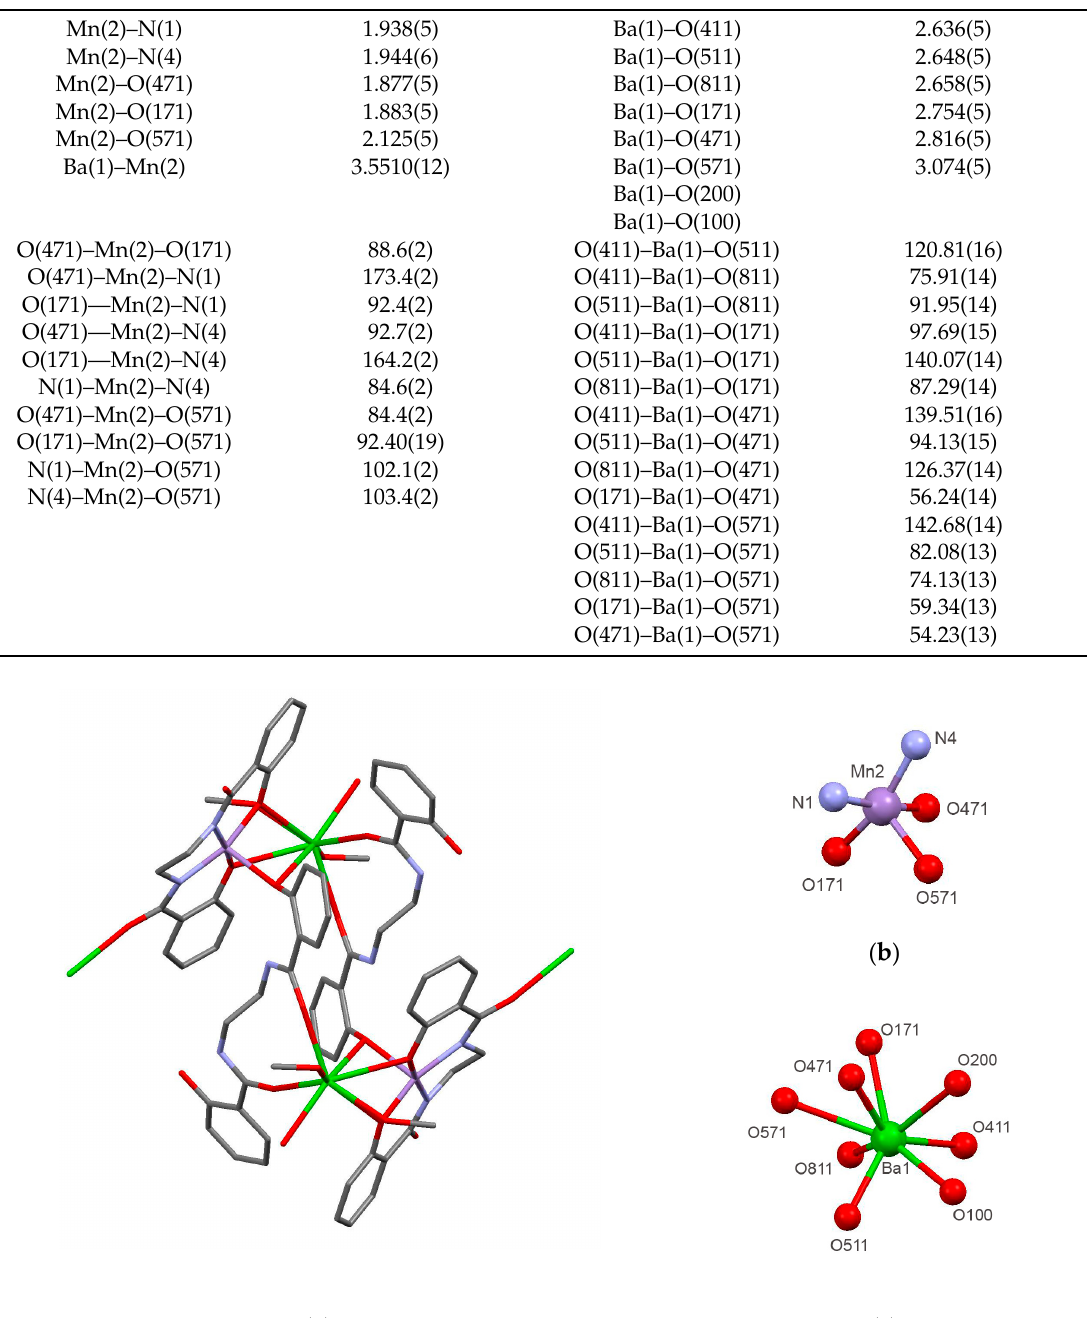
Table 2. Selected bond lengths (Å) and angles (°) for 1 .